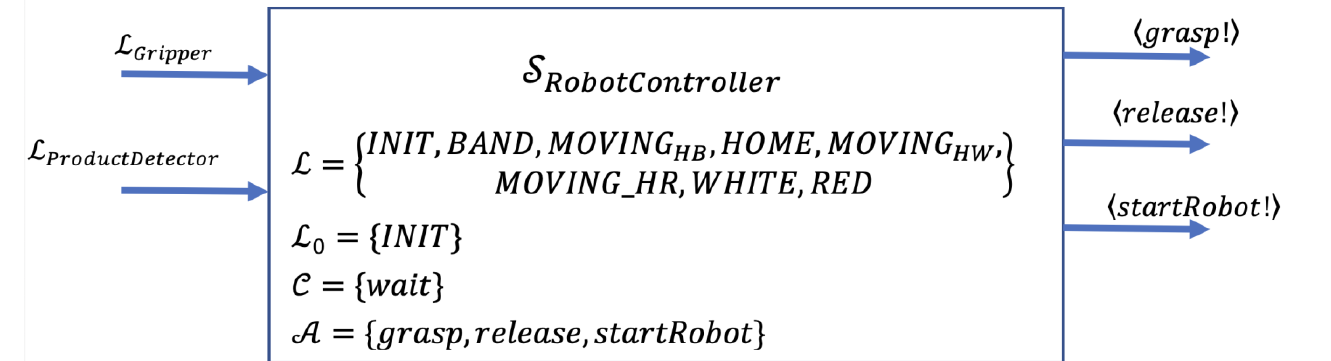
Figure 7. Block diagram of the robot controller module.